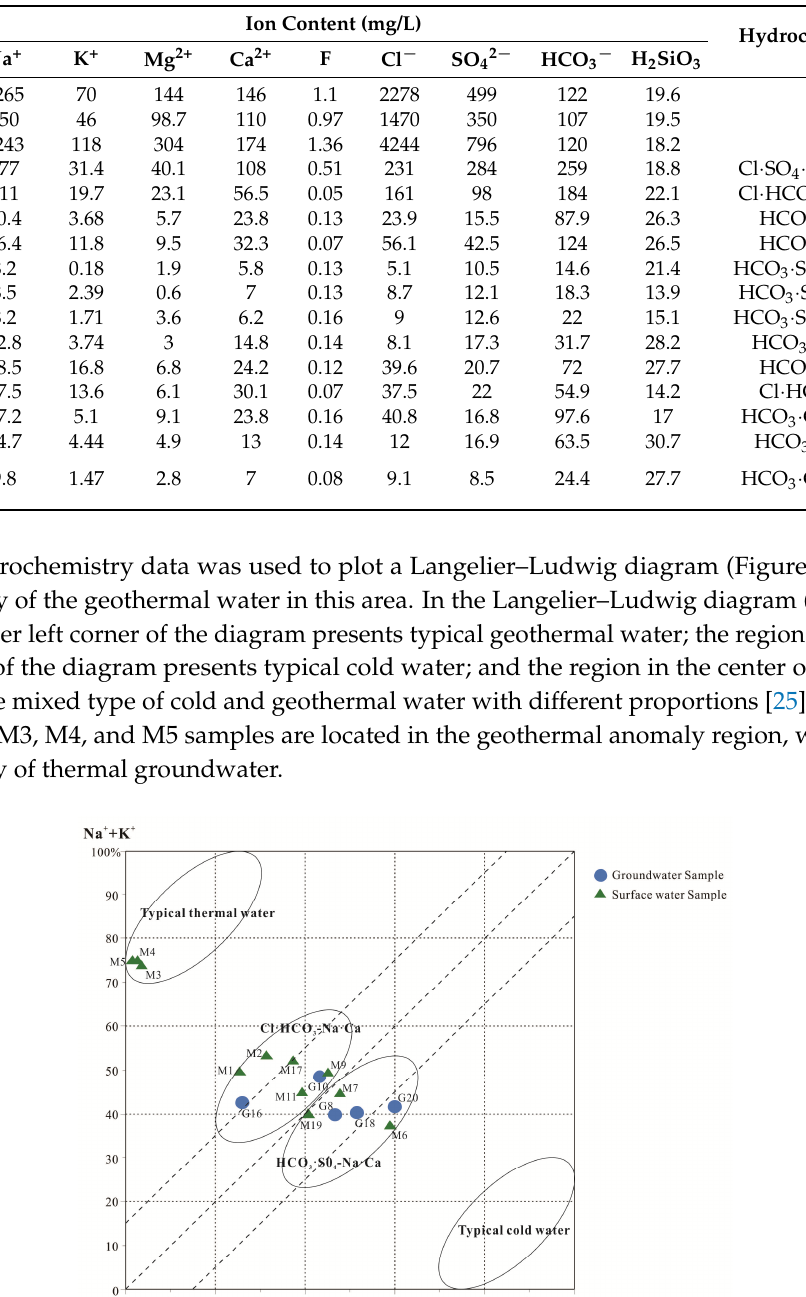
Table 1. Hydrochemical characteristics of water samples.